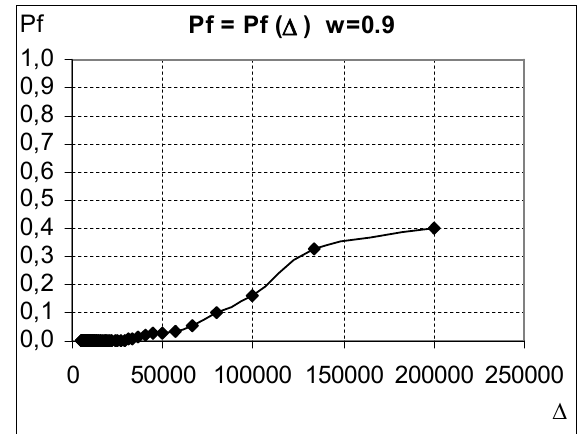
Fig 9. Failure probability in the case of m = 2 for the non- corroded specimens with specified life = 400000 cycles